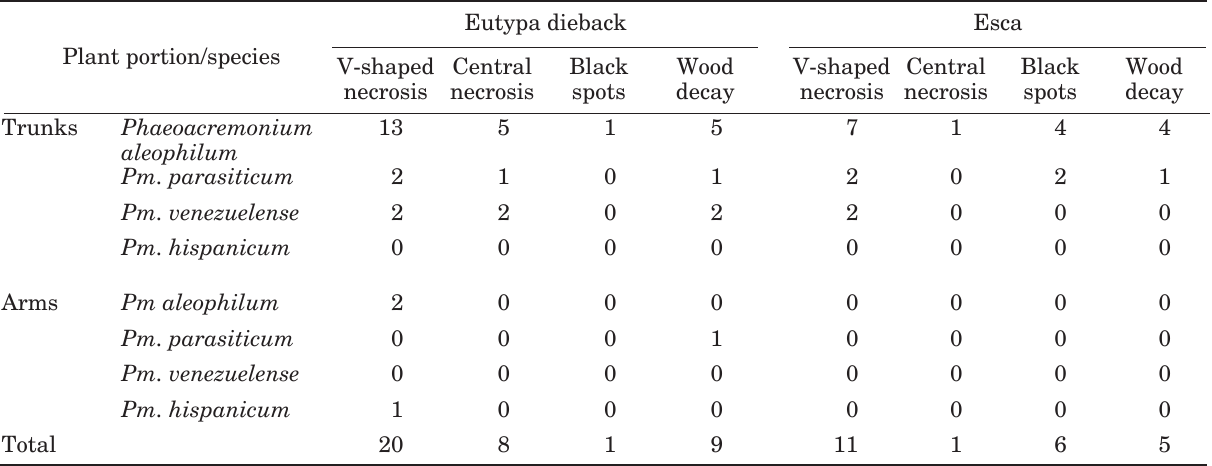
Table 2. Fungal species isolated from wood lesions of grapevine trunks and arms.